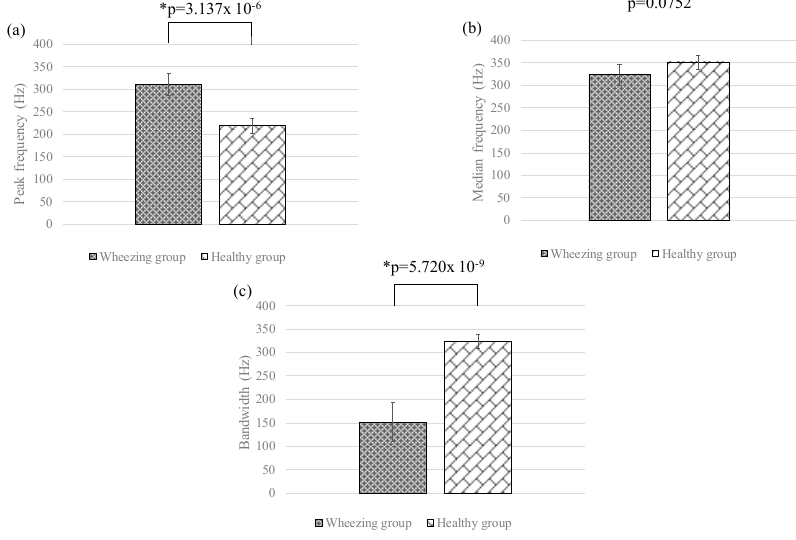
Figure 8. Means and standard deviations of ( a ) NSI 0Hz-250Hz ; ( b ) NSI 250Hz-500Hz ; and ( c ) NSI 500Hz-1000Hz for different groups. Here, * denotes significant difference. Sensors 2017 , 17 , 171